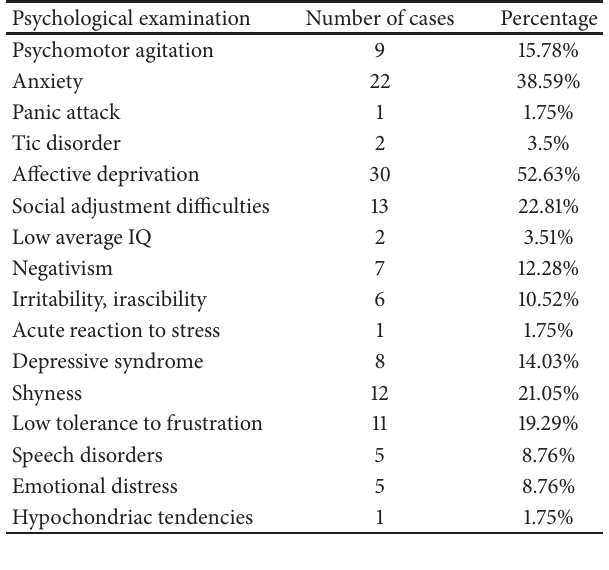
Table 4: Psychological evaluation.